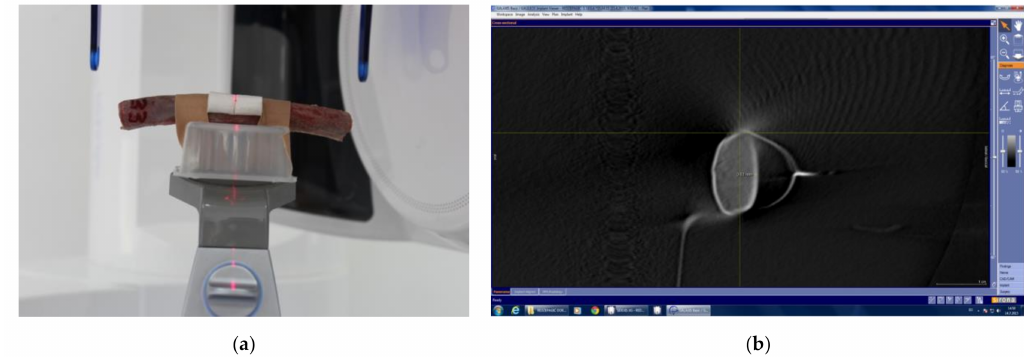
Figure 4. Sample positioned for scanning, implant insertion point placed at the center of the region of interest ( a ); measurements of pork rib cortical bone thickness (CBTC) by Galileos Implant Program (GALILEOS Implant Viewer) ( b